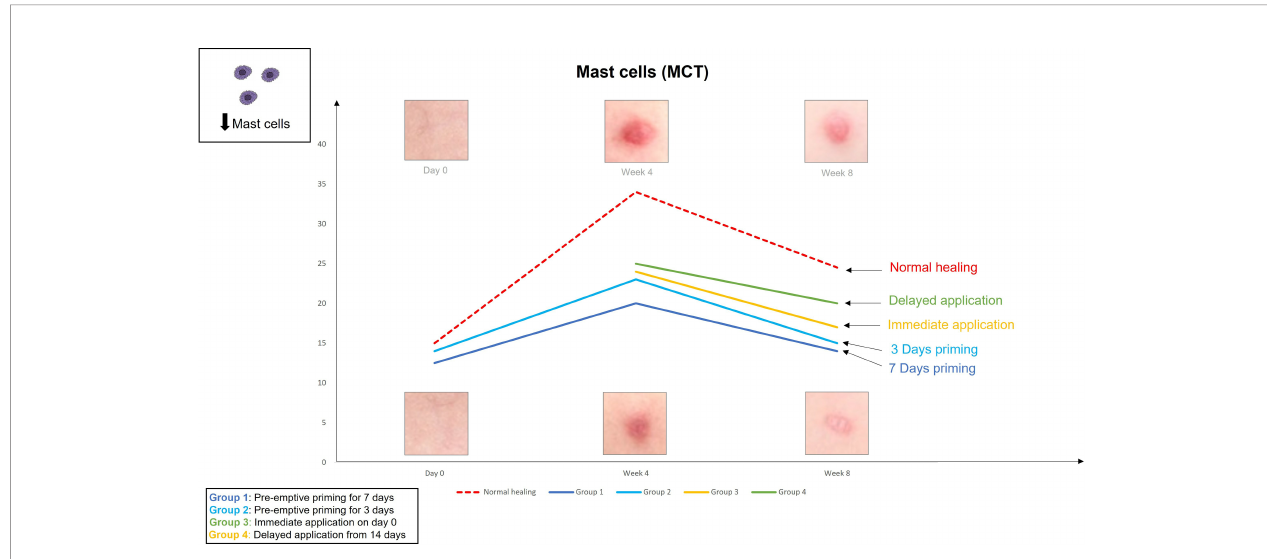
FIGURE 3 | We evaluated the pre-emptive, immediate and delayed intervention of topical Epigallocatechin-3-gallate (EGCG) on skin scarring by conducting a randomsied double blind controlled trial on 40 healthy volunteers over 8 weeks. Here, we demonstrate graphical representations of the trends. Application of topical EGCG, particularly 7 days prior to injury demonstrated greater reductions in mast cells, compared to the other modes of topical